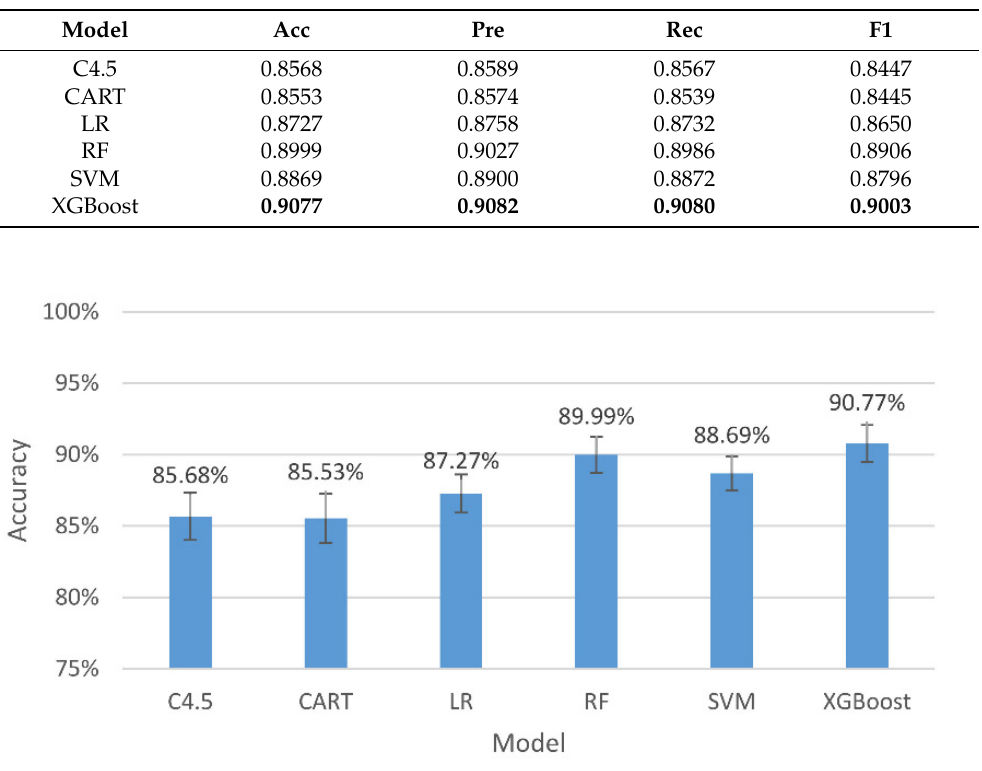
Figure 7. The accuracy and 95% confidence intervals of the personalizing models for the three-level classification (mean of all).